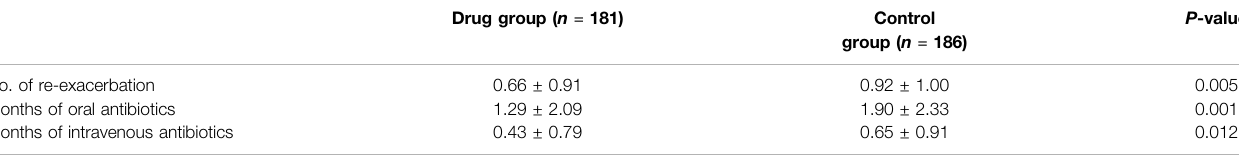
Data are presented as mean ± SD except as otherwise noted. No.,